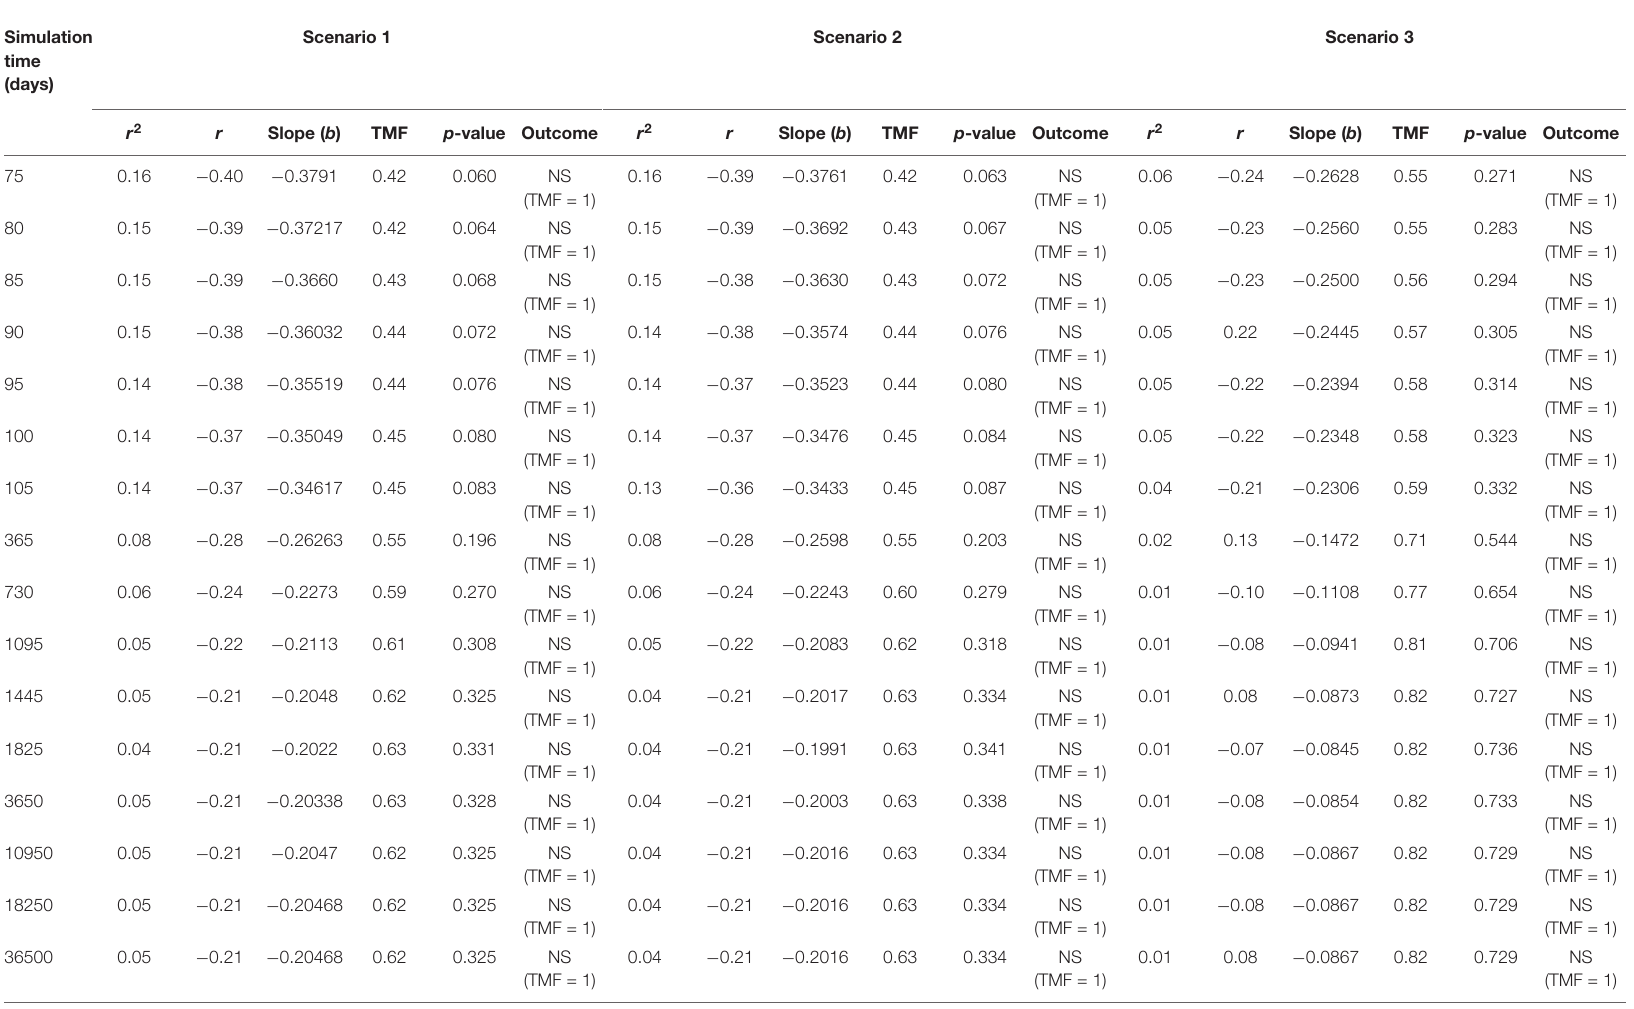
TABLE 2 | Apparent trophic magnification factors (TMF) and regression statistics for the linear regression models of the log of microplastic (MP) concentrations versus trophic level, representing the conditions under low (scenario 1: seawater [0.003 g/L] and sediment [0.266 g/kg dw]), moderate (scenario 2: seawater [0.010 g/L], and sediment [0.886 g/kg dw]) and high (scenario 3: seawater [0.040 g/L] and sediment [111 g/kg dw]) concentrations scenarios (see Supplementary Table S2 ) from 75 to 36500 days of simulation time, with a zooplankton elimination rate ( k E ) of